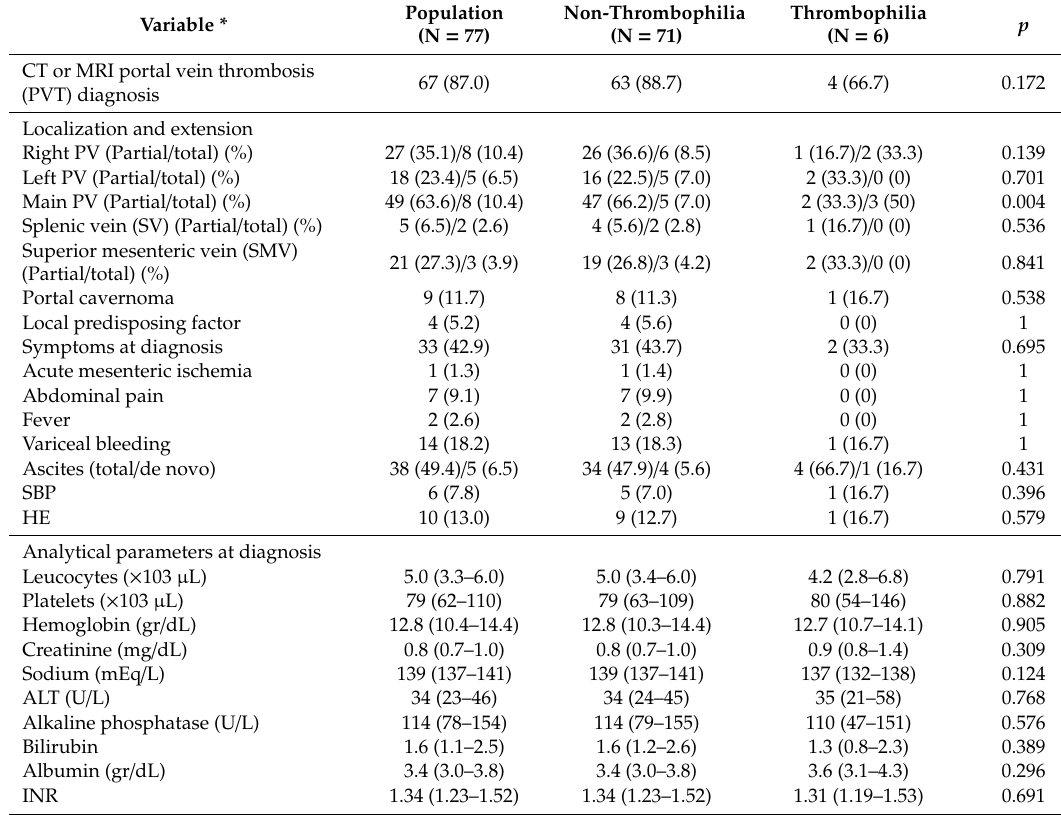
Table 3. Extension and clinical characteristic of portal vein thrombosis at diagnosis in the whole cohort and in patients with and without